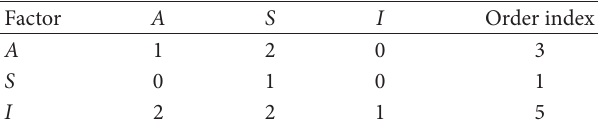
Table 3: Pairwise comparison matrix of 𝑈 1 based on 0–2 scale.